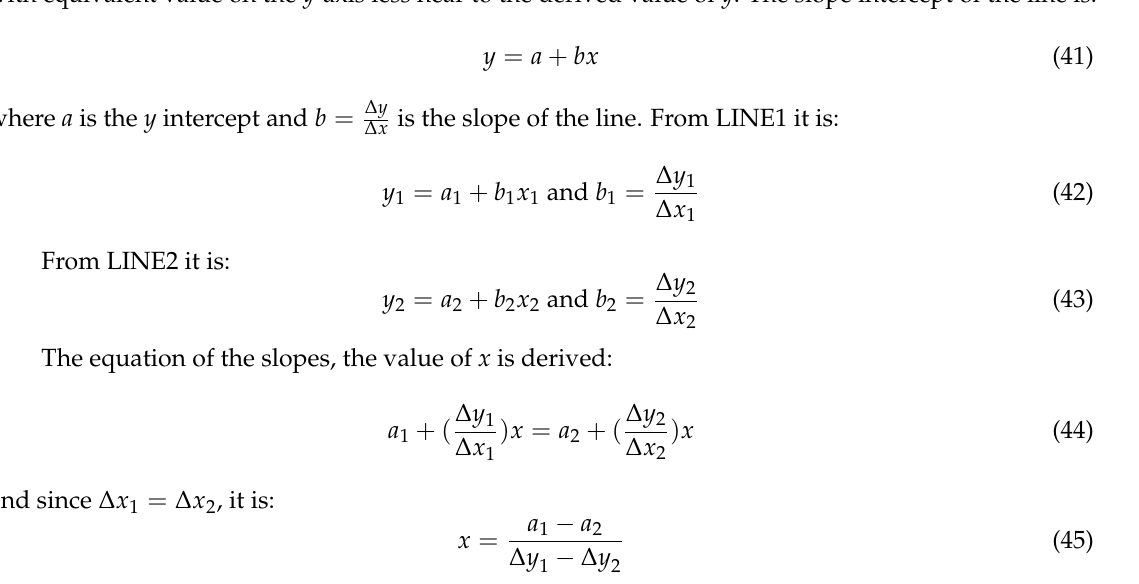
Figure 8. Schematic representation of the “knee” point detection method.